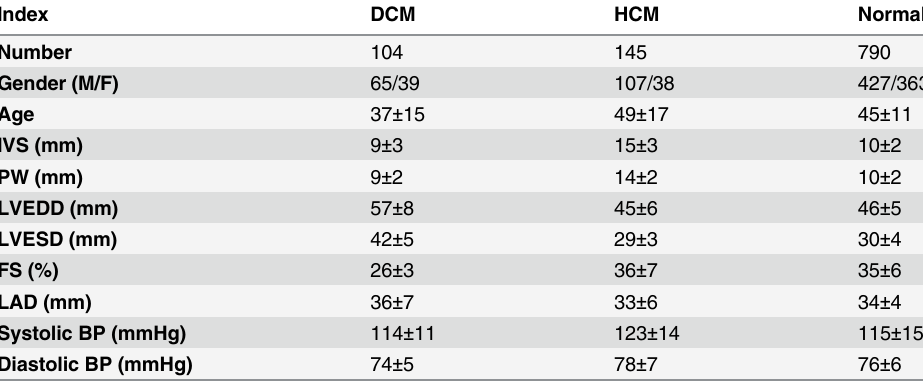
Table 1. Clinical Data in DCM and HCM Patient and Control